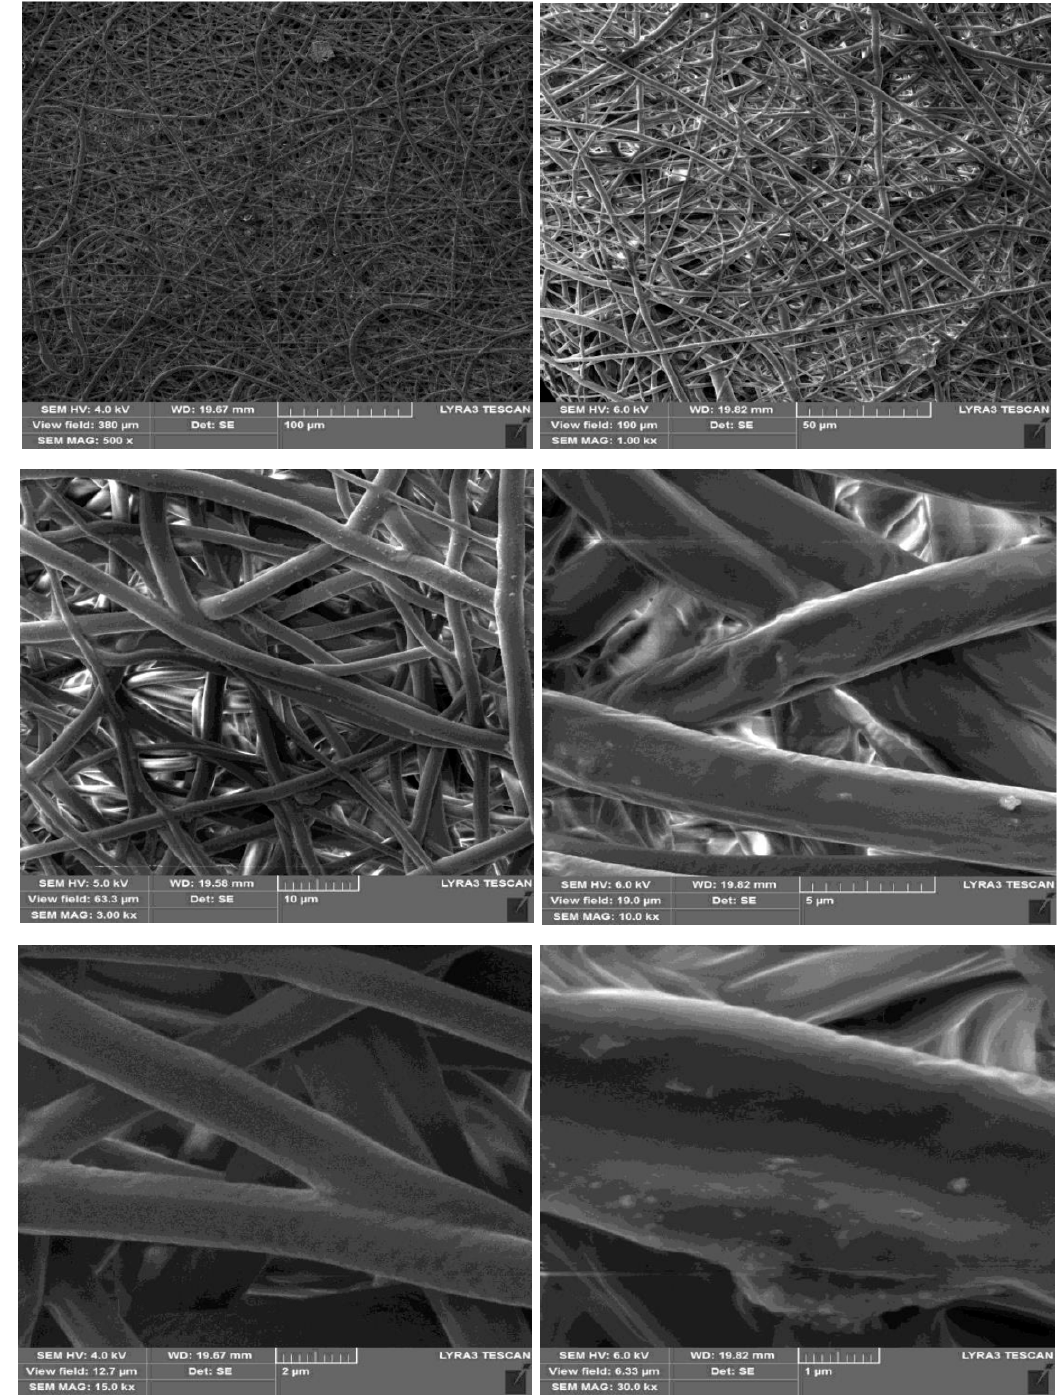
Figure 5. SEM micrographs of the blend 3 electrospun mats at different magnifications.